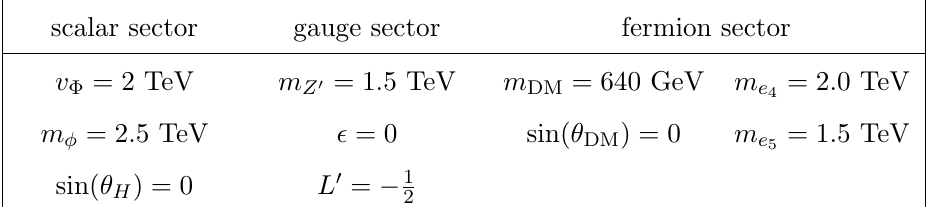
Table 2 . Default values for the model parameters (assuming y 0 throughout this paper, unless speci(cid:12)ed otherwise. For negligible sin( (cid:18) DM ), the mostly-doublet, heavy neutrino mass is given by m (cid:23)